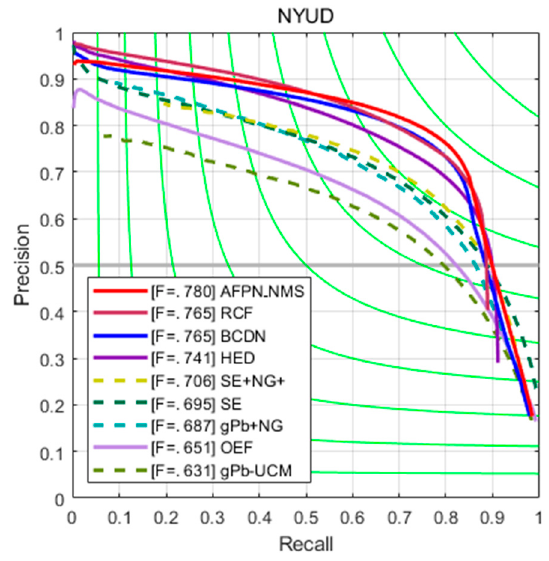
Figure 5. Comparison of edge detection results on the BSDS500 test dataset. Note that all the pre ‐ dictions are end ‐ to ‐ end outputs and not post ‐ processed.